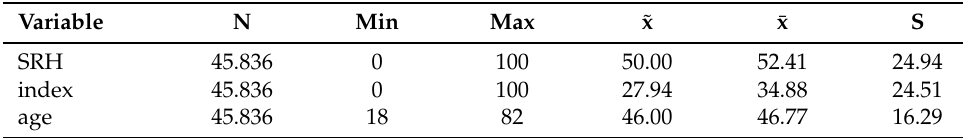
Table 3. Description of metric variables.